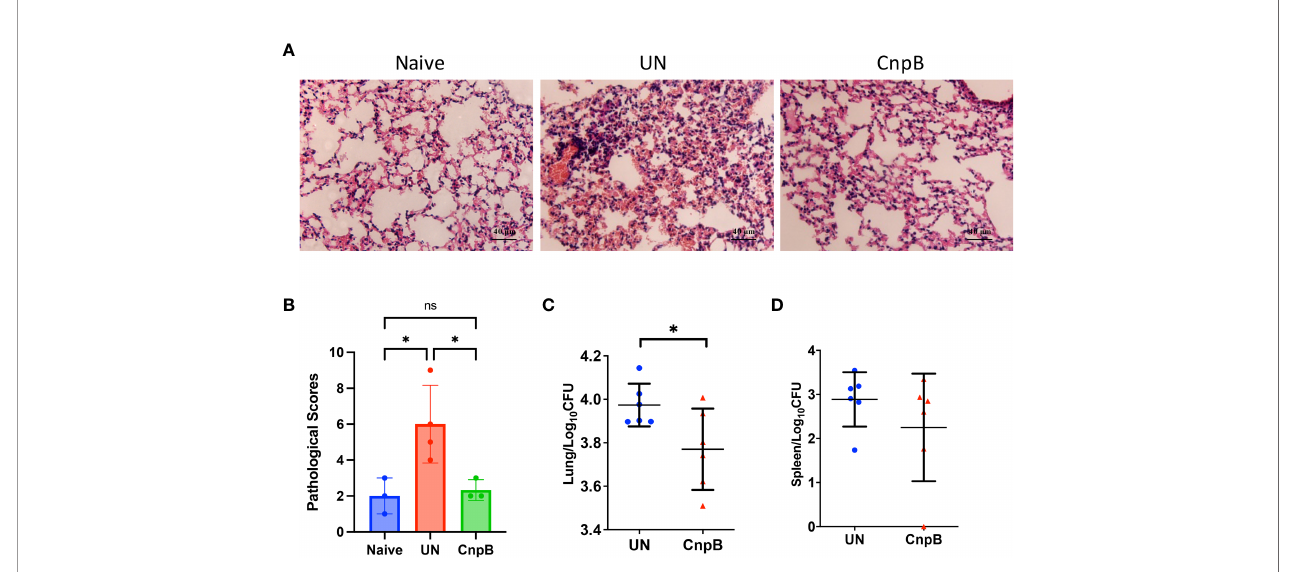
FIGURE 7 | Pathological changes and bacterial loads in CnpB immunized mice after M. tuberculosis intranasal infection. (A, B) Pathological observation (A) and scores (B) of lungs of CnpB-immunized mice with M. tuberculosis H37Ra intranasal infection ( n = 3 or 4). (C, D) Bacterial loads in the lungs (C) and spleens (D) of CnpB-immunized mice after M. tuberculosis H37Ra intranasal infection ( n =6), respectively. The results are expressed as mean ± SD. * P < 0.05, ns indicates no signi fi